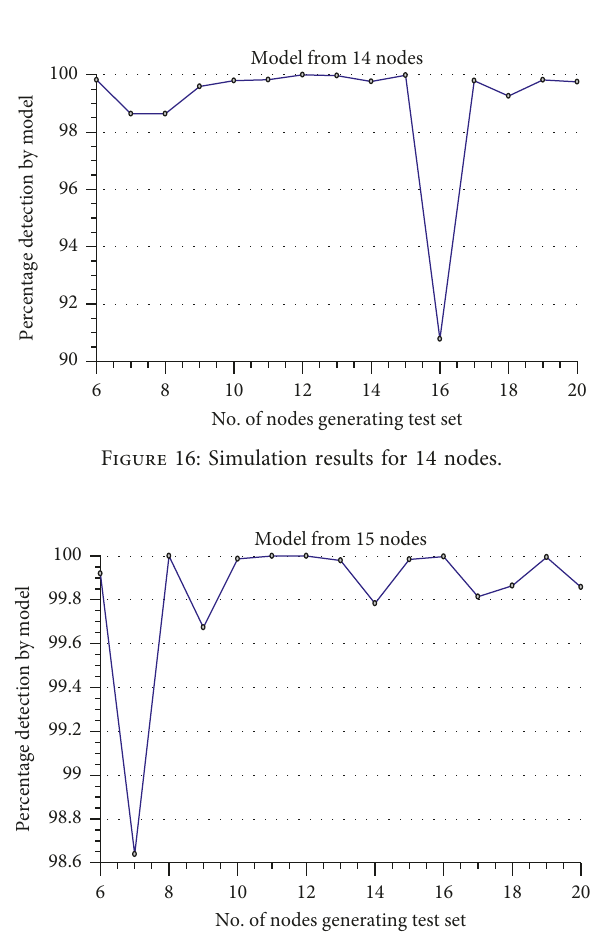
Figure 15: Simulation results for 13 nodes.